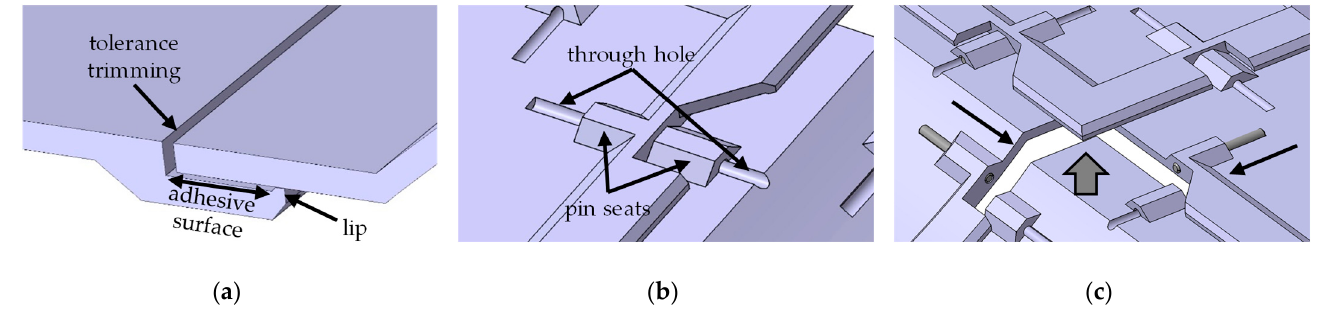
Figure 9. Design elements of the joggle lap and press fit composing the hybrid joint. ( a ) Joggle lap transmitting forces and lip for ensuring adhesive thickness; ( b ) trimmed tongue and pins to allow for tolerance compensation in X-direction; ( c ) through holes to accommodate pins during assembly.